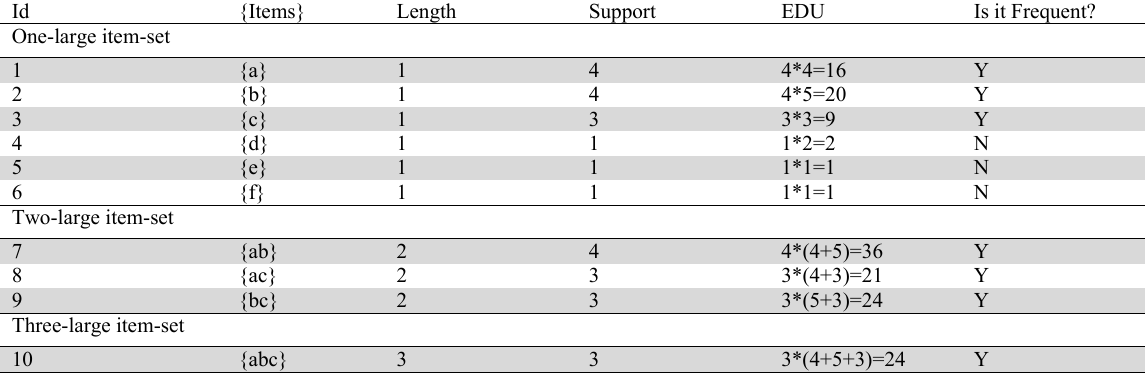
The progress of finding frequent item sets in cluster